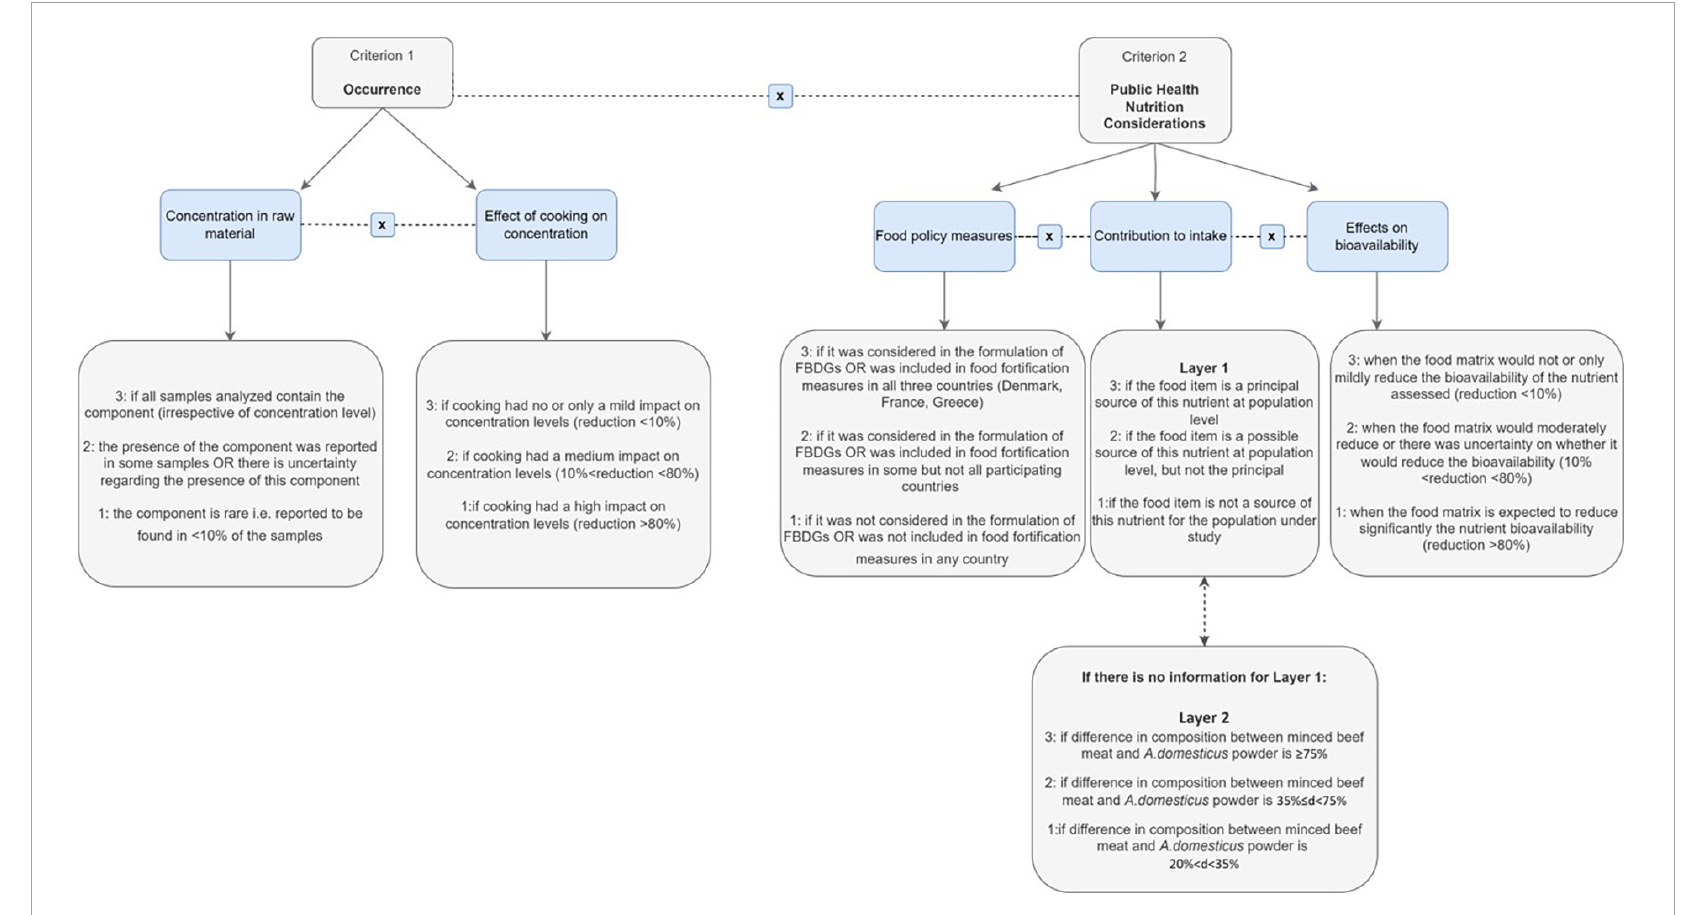
FIGURE4 Definition of sub-criteria of occurrence and severity considered in